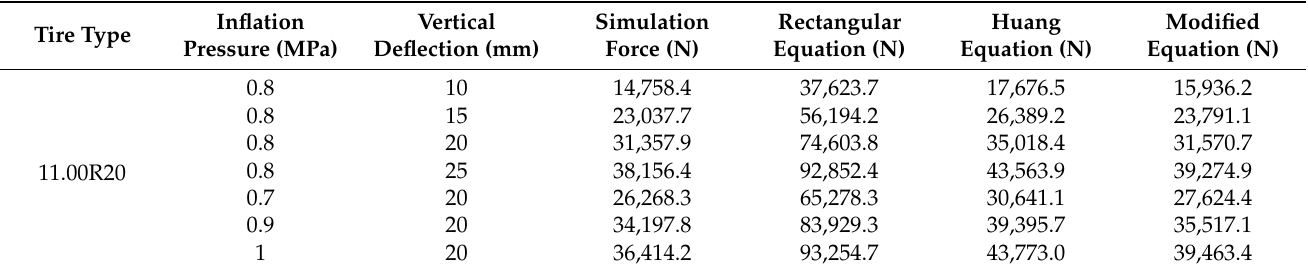
Table 4. Contact forces of truck